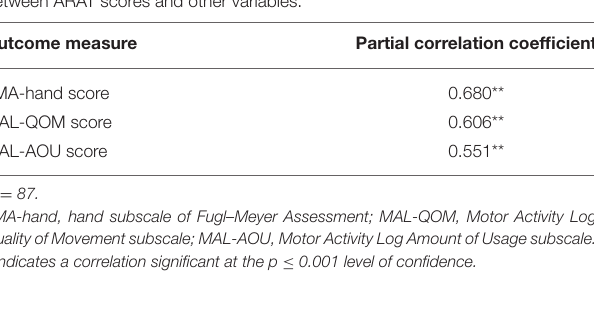
TABLE 3 | Partial correlation coefficients (controlling for using a walking aid) between ARAT scores and other